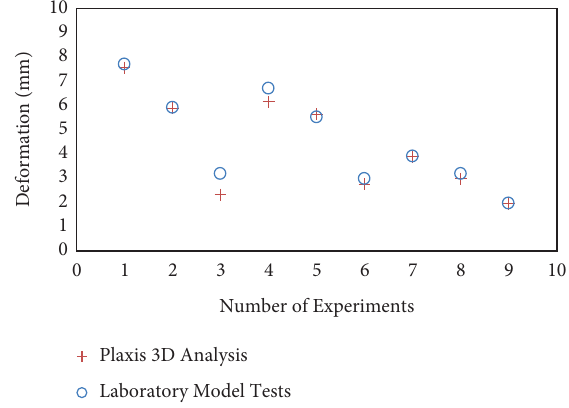
Figure 20: Comparison of data from numerical analyses and laboratory experiments.